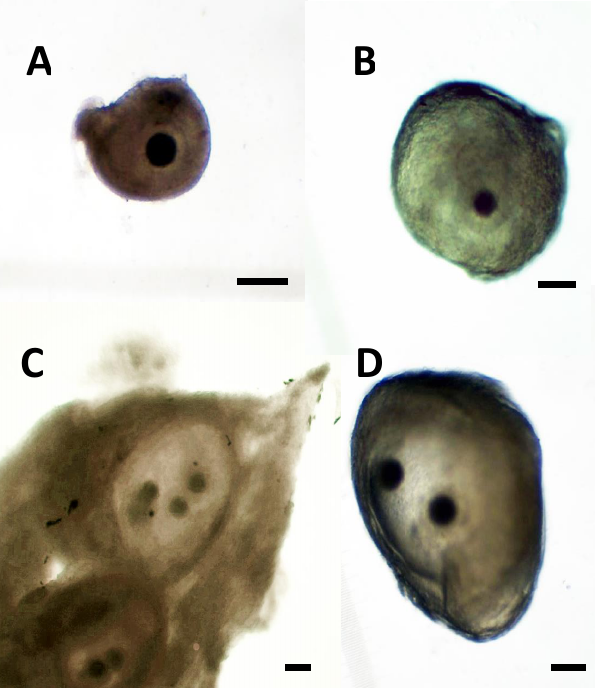
Figure 1. Representative photographs of ( A , B ) mono-ovular follicles with just one oocyte inside and ( C , D ) poly-ovular antral follicles with two or more oocytes inside each follicle. Bar = 100 μm , 40× magnification.